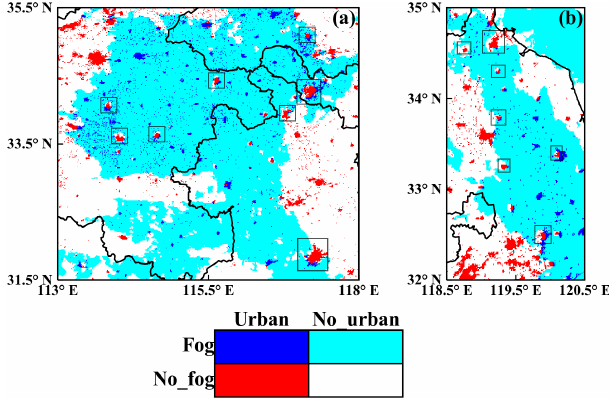
Figure 3. Two sub-regions (a, b) with obvious fog holes in the Hi- mawari 8 image at 11:00 on 3 January 2017. The fog zone, which is represented by albedo > 0 . 45 (at 0.64µm) and brightness tempera- ture > 266K (at 12.4µm) (Di Vittorio and Emery, 2002), is marked with cold colours (blue or cyan). The urban areas are marked with dark blue or red. The red and white pixels surrounded or semi- surrounded by cold colours are fog holes, and among these pixels, the red pixels indicate the fog holes over urban areas. Some of the cities with fog holes are marked by